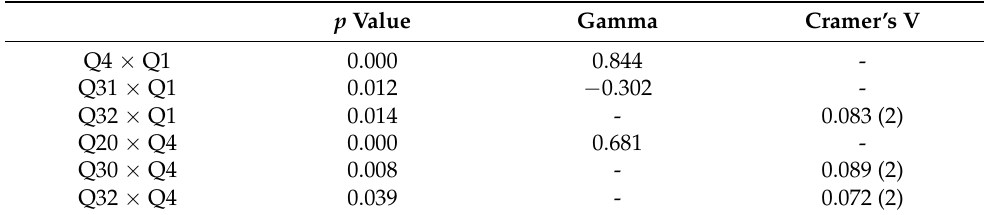
Table 5. Summary of the measures of the chi-square χ 2 test for the cross tables presented in Tables 3 and 4. Gamma is used for ordinal variables, while Cramer’s V (degrees of freedom) is used for nominals by ordinal